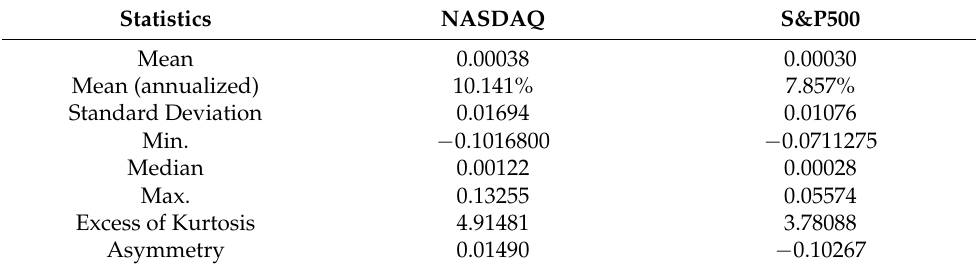
Table 1. Descriptive statistics for log-returns series of daily NASDAQ and S&P500 stock